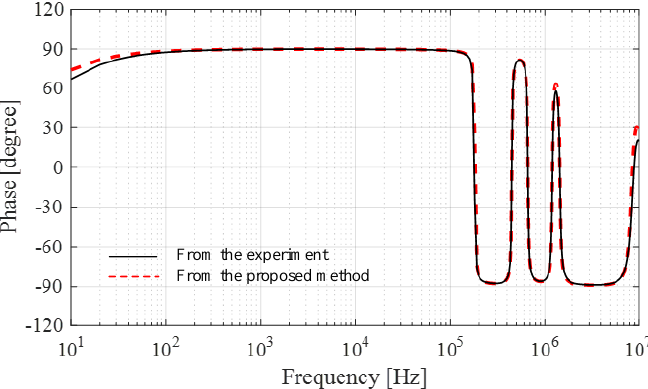
Figure 11. Phase of input impedances of the reactor from the measurement and by the proposed method.